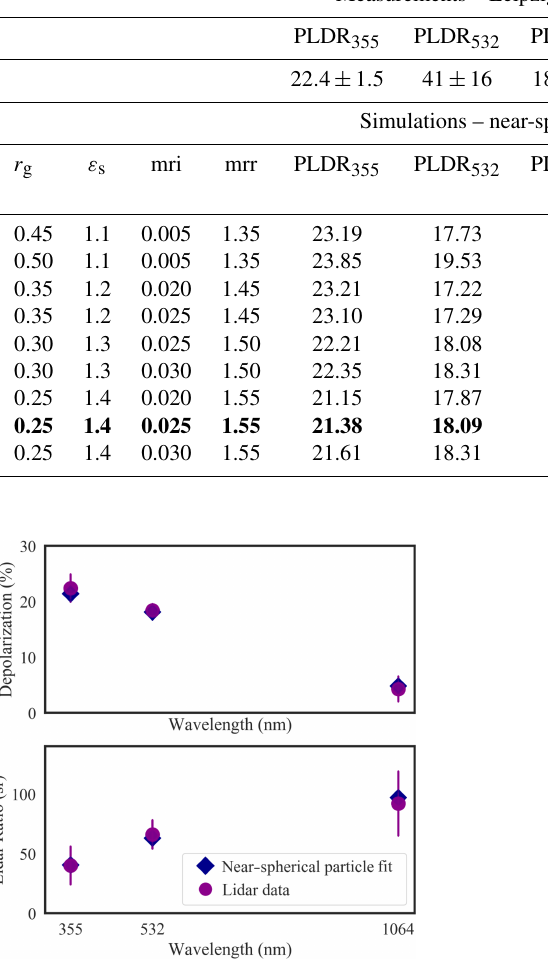
Figure 10. Same as Fig. 8 but only for the solution found to minimize the cost function of Eq. (8). Again, purple circles and lines correspond to measurements and measurements uncertain- ties on 22 August 2017, in Leipzig, Germany, while dark blue diamonds correspond to simulations assuming near-spherical par- ticles of mean axial ratio ε s = 1 . 4, mean geometric radius r g = 0 . 25µm and a wavelength-independent complex refractive index m = 1 . 55 + i 0 . 025 (this is the solution highlighted in bold in Ta- ble 3).